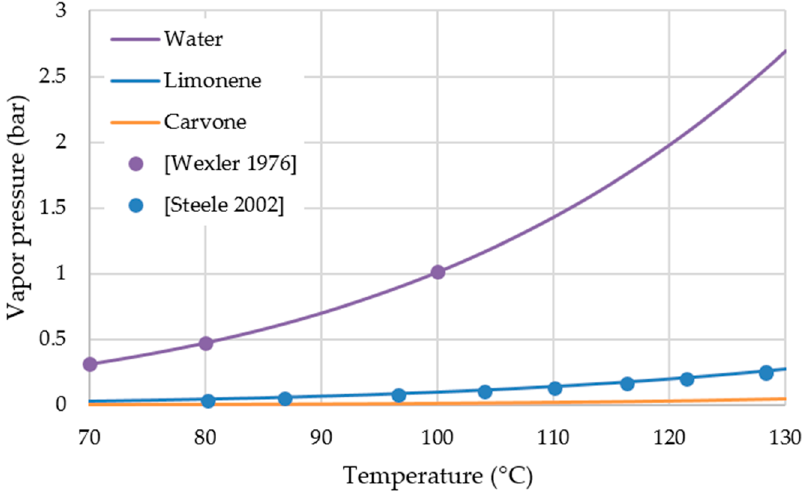
Figure 11. Brunauer isotherms of the caraway system.